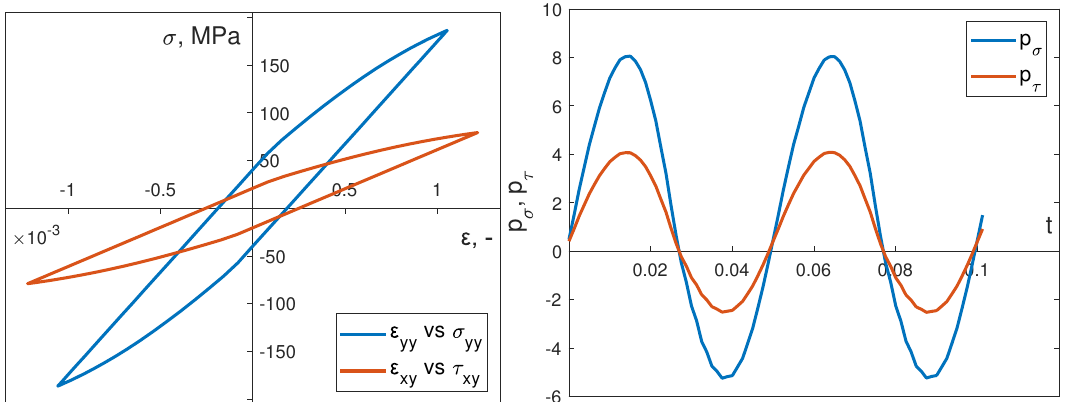
Figure 11. Stabilized calculated hysteresis loops for dynamic in-phase load and calculated instantaneous power (bending) p σ and torsion p τ